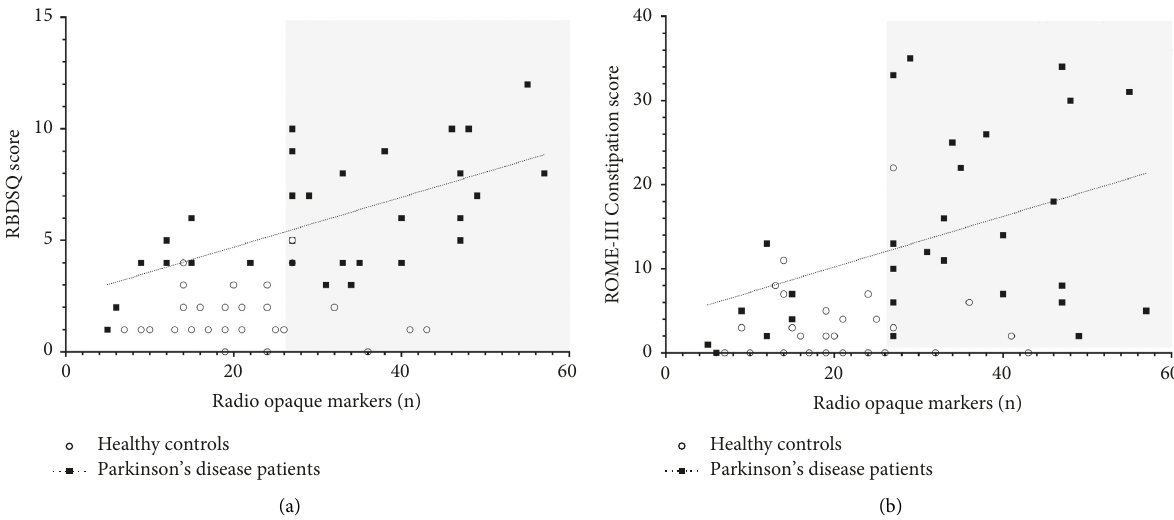
Figure 3: (a) Association between RBDSQ score and total number of retained radio-opaque markers (ROM) in the gastrointestinal tract. The dotted line indicates the linear regression line (linear regression slope for PD patients of 0.1119, r � 0.61, p � 0 . 0003). The grey box indicates a tentative cutoff for prolonged intestinal transit time. (b) Association between ROME III functional constipation score and total number of retained radio-opaque markers (ROMs) in the gastrointestinal system. The dotted line indicates the linear regression line (linear regression slope for PD patients of 0.30, r � 0.40, p � 0 . 029) in the PD patient group. The grey box indicates a tentative cutoff for prolonged intestinal transit